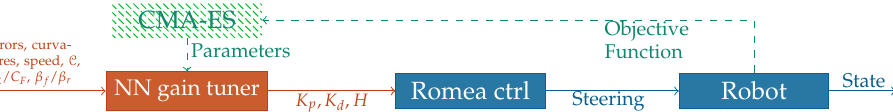
Figure 2. Overview of the gain tuning method. Dashed section designates the optimizer that is used only for